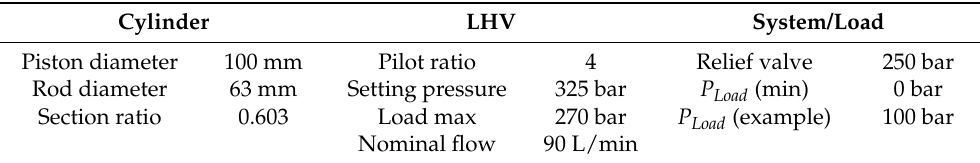
Table 1. The specifications of the primary hydraulic components of the hydraulic circuit imperative to depict graphs included in Figures 3 and